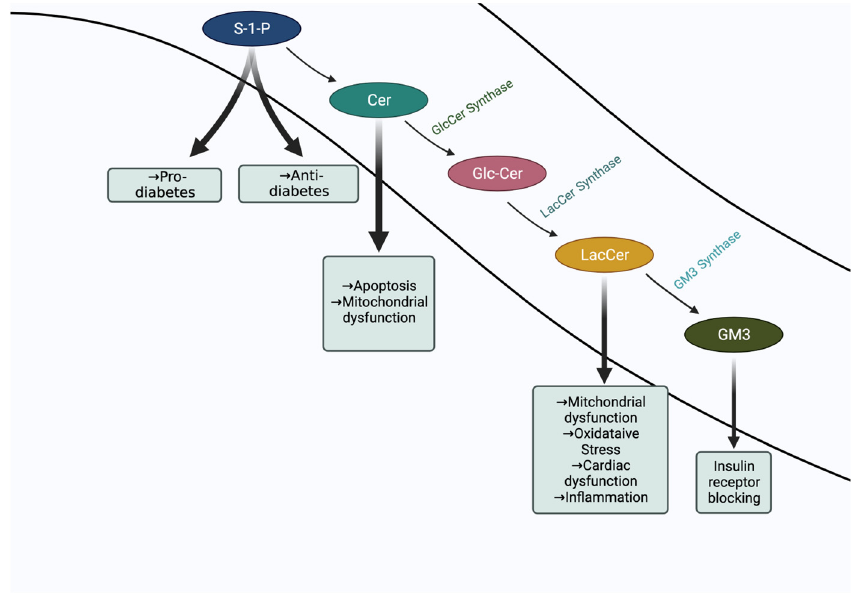
Figure 4. Schema of the Roles of Sphingolipids in Multiple Phenotypes in Diabetes Disease Pathol-